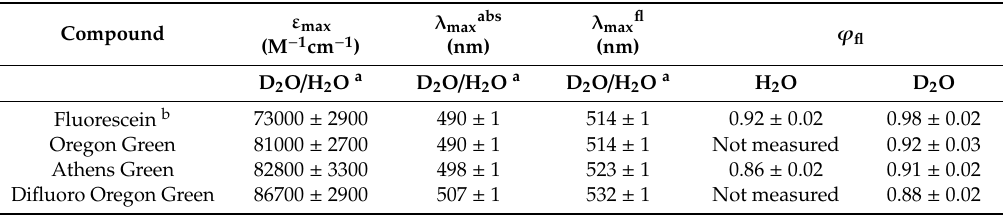
Figure 4. Normalized absorption ( A ) and fluorescence ( B ) spectra of the four compounds dissolved in D 2 O-PBS (pD = 7.8). Spectra recorded from H 2 O-PBS solutions are identical. Note that the spectra for fluorescein and Oregon Green are similar (black and red lines, respectively). Table 1. Extinction coe ffi cients at the peak of the absorption band ( ε max ), the absorption ( λ maxabs ), and fluorescence ( λ maxfl ) band maxima, and fluorescence ( ϕ fl ) quantum yields, all recorded from air-saturated PBS bu ff ered solutions at pH = 7.4 or pD =